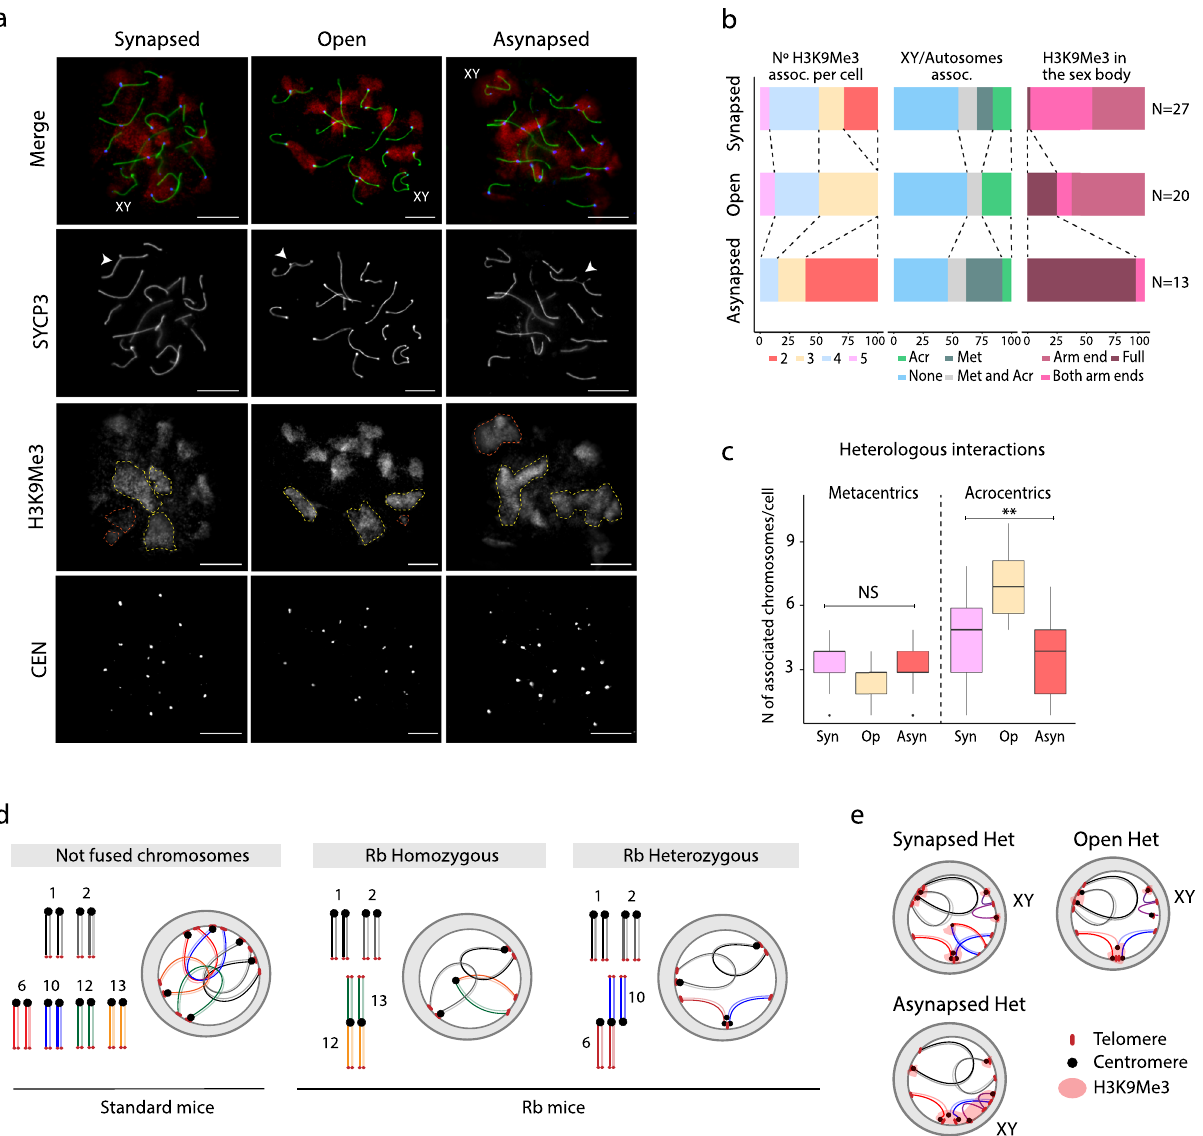
Fig. 4 Interchromosomal associations. a Examples of immuno fl uorescence on primary spermatocytes at pachytene stage, labeling the synaptonemal complex with SYCP3 (green), the centromeres (CEN, blue), and H3K9Me3 (red). Immuno fl uorescence replicates, n = 3. SYCP3 staining allowed for the detection of the different heterozygous Rb fusion according to synapsis pattern: synapsed, open, and asynapsed (white arrows). H3K9Me3 shows associations between different chromosomes (yellow dashed lines) and differential distribution in the XY sex body (orange dashed lines): in both arms (as shown in the synapsed example), in one arm end (as shown in the open example), or fully around the sex body (as shown in the asynapsed example). The sex body is indicated as XY. Scale bar = 10 µ m. b Analysis of H3K9Me3 associations according to synapsis states (synapsed, open, and asynapsed) of heterozygous metacentrics (left panel), sex chromosome/autosome associations (central panel), and the sex body on its own (right panel). Acr acrocentric chromosomes, Met metacentric chromosomes, assoc. association. N = number of cells analyzed. Source data are provided as a Source Data fi le. c Number of associated chromosomes (metacentrics ( n = 60)) or acrocentrics ( n = 60)) detected per cell depending on the synapsis state of heterozygous metacentrics (Kruskal – Wallis, ** P ≤ 0.005, one-sided). Boxplots are presented as mean values (center line) ± SD. syn synapsed, op open, asyn asynapsed, ns nonsigni fi cant. Source data are provided as a Source Data fi le. d Schematic representation of chromosome organization in P/D according to the presence of Rb fusions. In standard mice, all chromosomes are acrocentric and are attached to the nuclear lamina. When Rb fusions are present, chromosome organization is disrupted, affecting chromosome disposition inside the nucleus, either in a homozygous or a heterozygous state. e Schematic representation of the centromeric associations detected with the H3K9Me3 signal in addition to the XY disposition according to synapsis pattern of heterozygous Rb fusions (i.e., synapsed, asynapsed, or open). het heterozygous